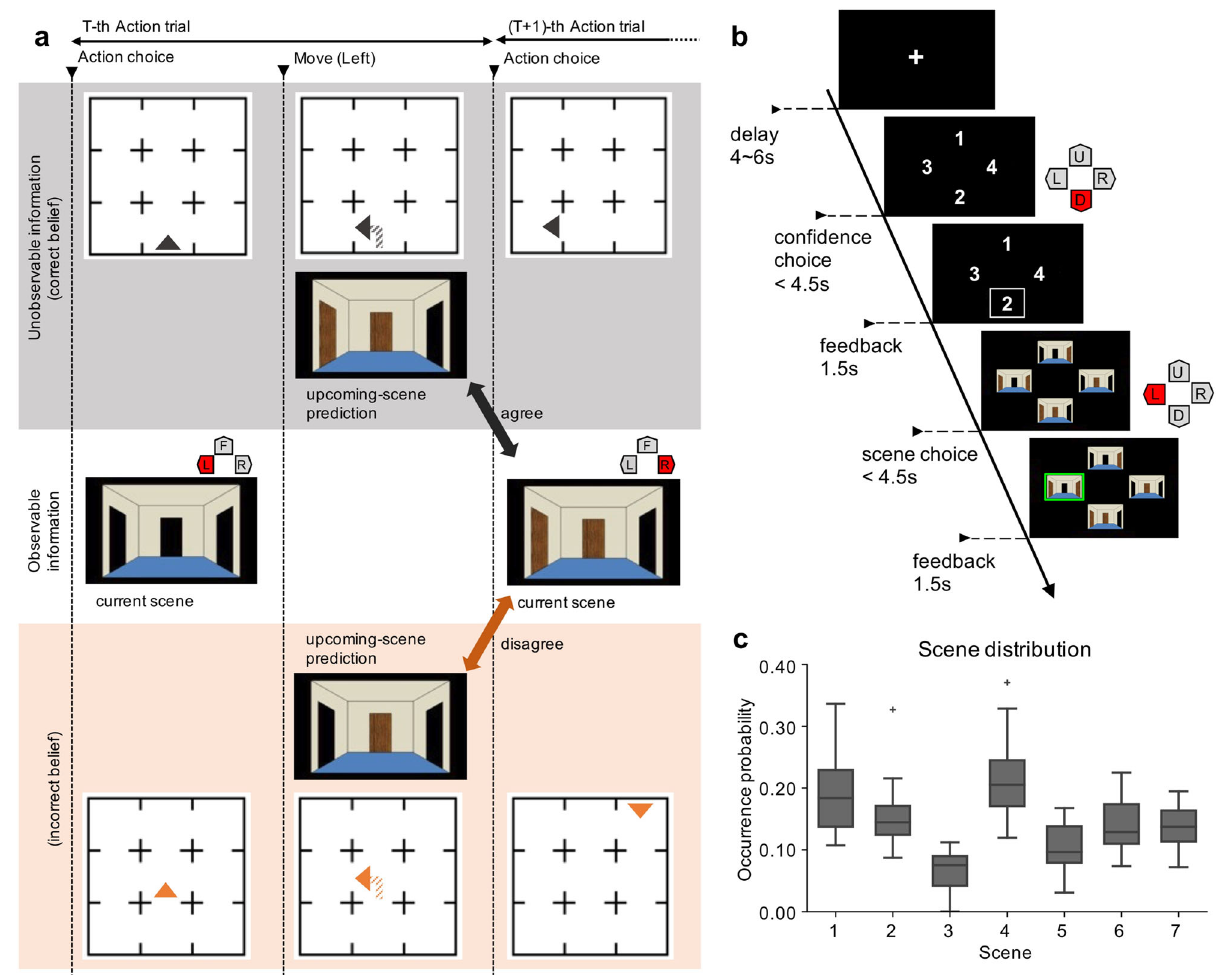
Fig. 1 Maze navigation task. Subjects explored the pre-learned grid maze from an unknown initial state and were intermittently asked to predict the upcoming scene and estimate their con fi dence level for that prediction. To successfully perform the task, subjects needed to infer their current state based on the history of actions and previously observed scenes. a A sample action trial sequence. At the beginning of each trial, subjects observed the scene from their current state (i.e., the status of the doors to the left, forward, and right) and then chose an action allowing them to move in one of those three directions. The doors were either open (passable; black) or closed (impassable; brown). Only open doors allowed the subjects to move to an adjacent state in the grid and to see its scene. If a subject ’ s state inference (i.e., belief) was incorrect, the observed scene in the subsequent trial would differ from their prediction. Subjects performed 1 – 5 consecutive action trials between prediction trials. The 3 × 3 maze in this fi gure is used to explain the task, and the maze used in the actual experiment was of a 5 × 5 size (Supplementary Fig. S1a). b A sample prediction trial sequence. In the prediction trial, a fi xation cross was displayed for 4 – 6 s (delay period) during which time the subjects were asked to predict the upcoming scene. Next, the subjects reported their con fi dence level for the upcoming scene prediction on a scale from 1 (low) and 4 (high). Then they were asked to select their prediction of the upcoming scene from four options, consisting of the true scene and three distractor scenes. A green or red frame was presented around the selected scene to re fl ect a correct or incorrect choice, respectively. c Occurrence probabilities for each scene selected by subjects as the predicted upcoming scene. There were seven types of scenes based on combinations of door statuses in each scene within the maze (no dead-end, i.e., three closed doors). Center lines of the box plots indicate the medians, boxes indicate the lower and upper quartiles, and the whiskers represent 1.5× interquartile range (IQR). Cross-markers indicate the F (1,5435) = 77.83, p = 1.5 × 10 − 18 ) across all subjects. Similarly, scene choice RTs were shorter in the correct trials than in the incorrect trials ( F (1,5435) = 33.89, p = 6.2 × 10 − 9 ). There was no interaction effect between the prediction correctness and